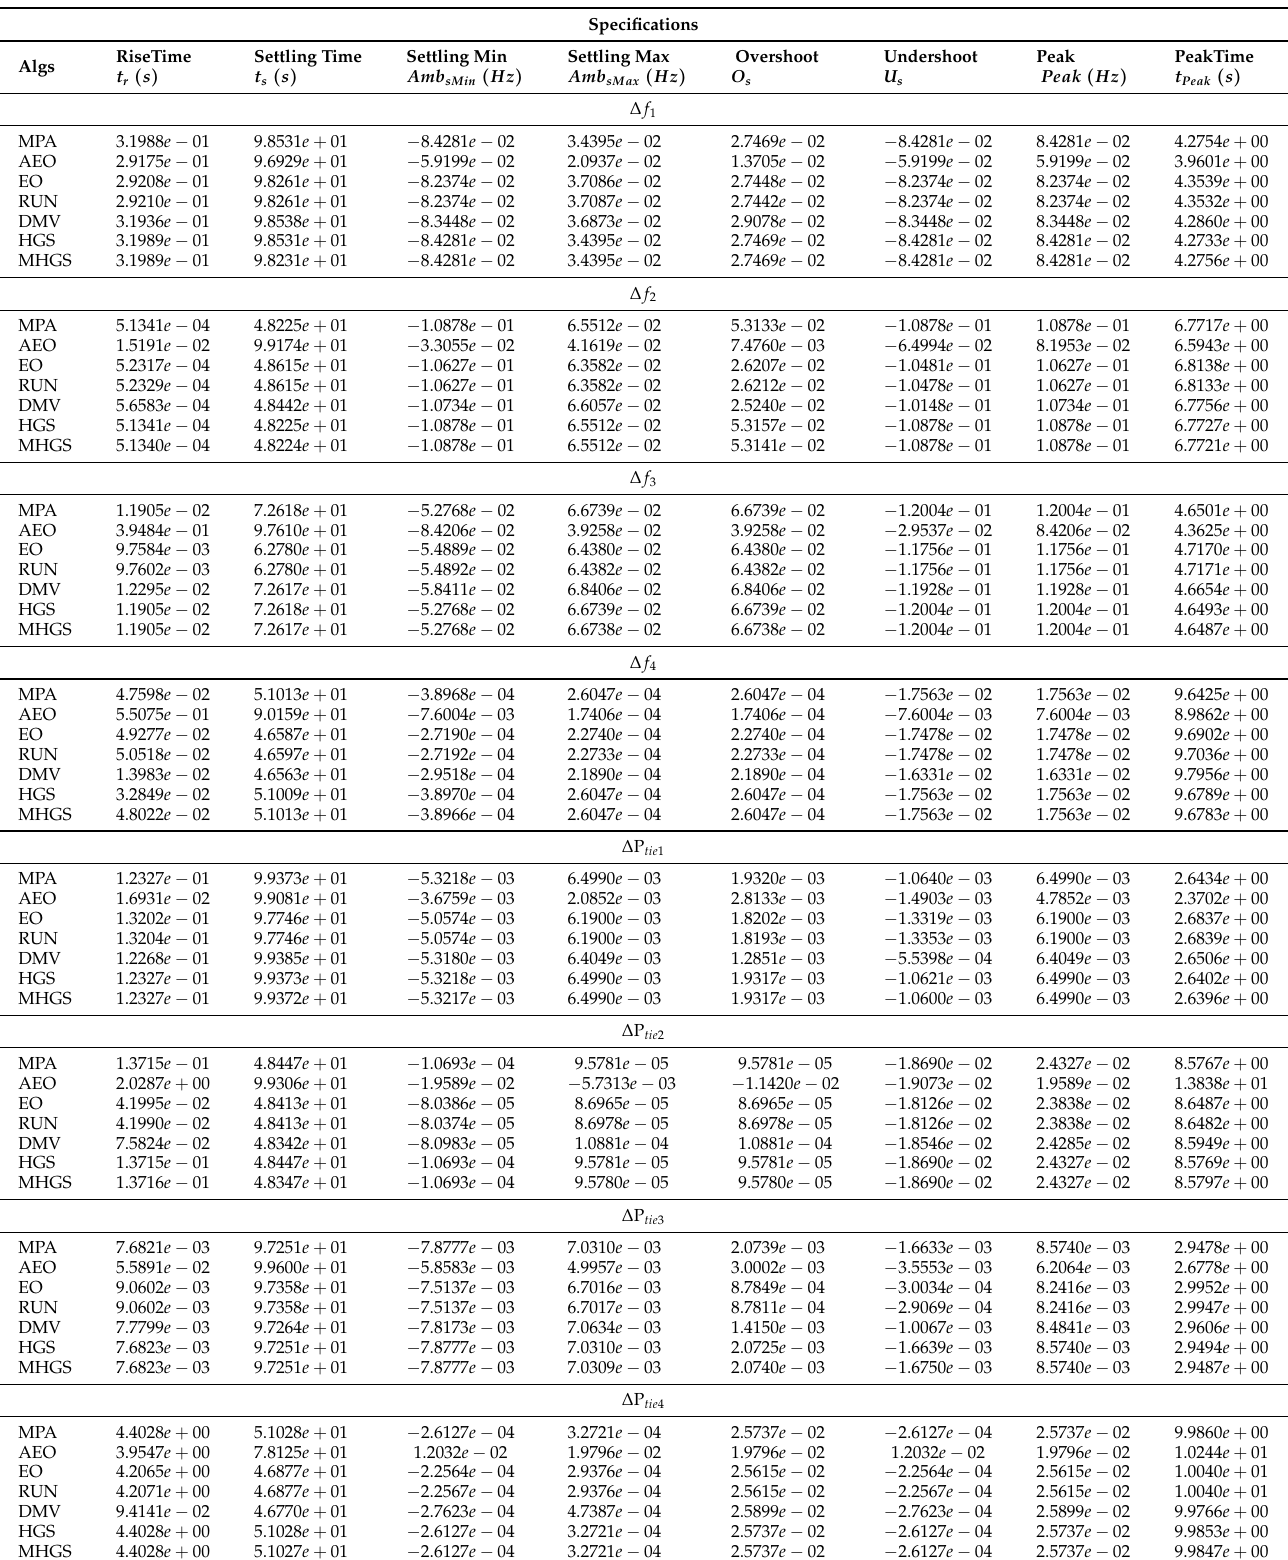
Table 4. Response properties of frequencies and tie-line powers’ deviations at 1% load disturbance applied on area 2 of the four connected